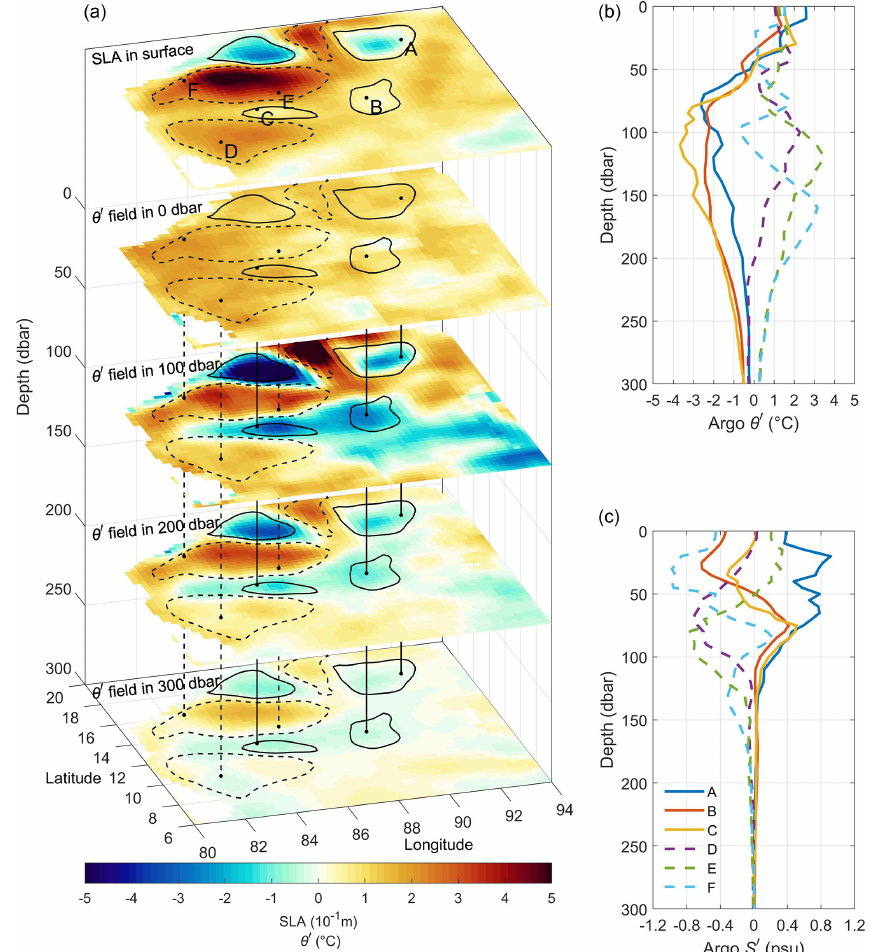
Figure 2. (a) A case of matching identified eddies from sea level anomaly (SLA) fields with vertical temperature anomaly θ (cid:48) and salinity anomaly S (cid:48) fields on 20 May 2017. The top layer represents the SLA fields and identified eddies, where solid and dashed lines represent cyclones (CEs) and anticyclones (AEs), respectively. The colors in the lower layers represent the temperature anomaly θ (cid:48) field at different depths from the ARMOR3D data. The vertical solid and dashed lines represent Argo profiles located in CEs and AEs, respectively, and each profile is marked by a letter (A–F) in the top layer. (b, c) The graphs on the right show the vertical temperature and salinity anomaly profiles of the Argo buoy (A–F) located in the eddies.